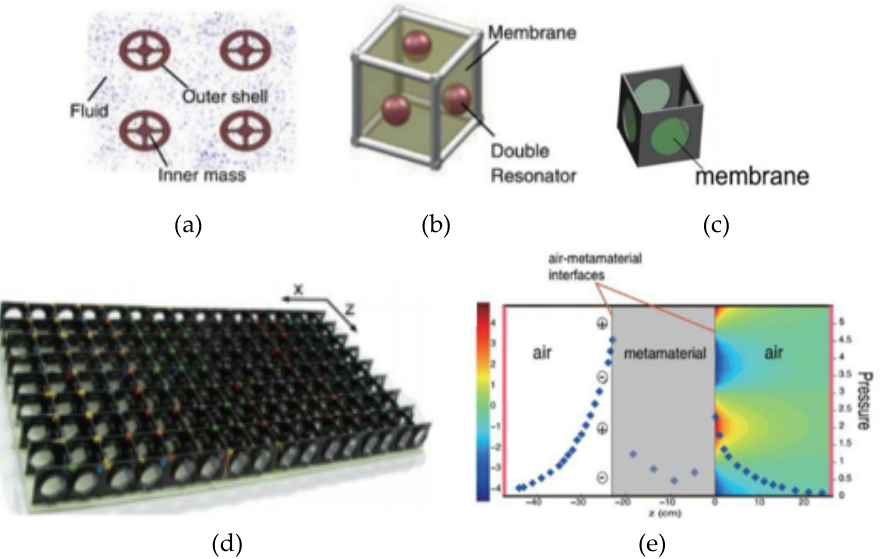
Figure 22. ( a – c ) Evolution of a floating double resonator to a thin film structure; ( d ) Negative mass density system; ( e ) Amplified evanescent wave [77].